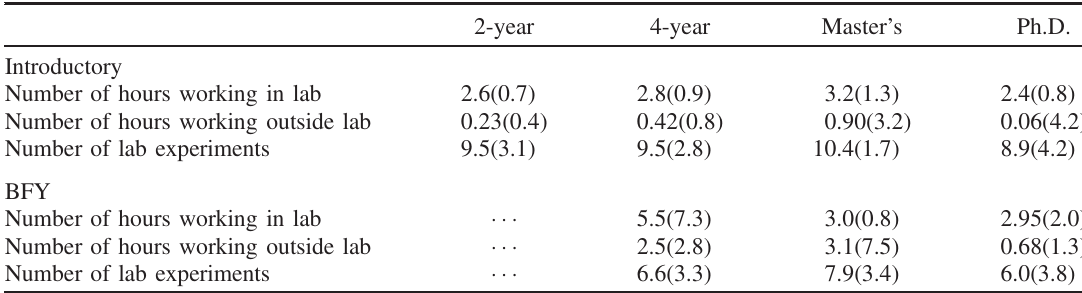
TABLE III. Average number of hours students spend working in the lab and outside of lab on lab activities for each type of institution. Additionally, the average number of total lab experiments per term is shown. The standard deviation of these distributions is shown in